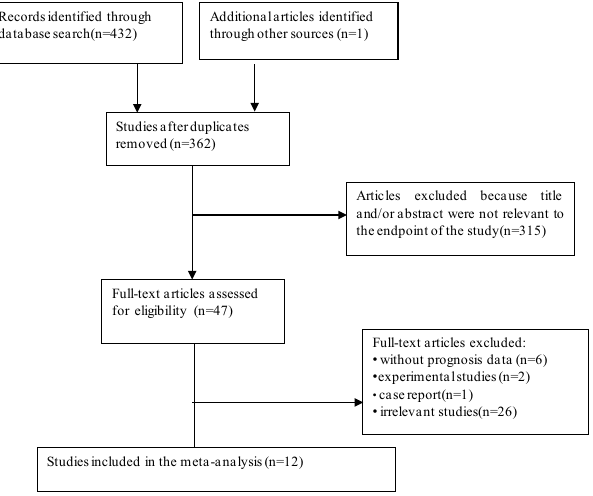
Figure 1. The flow chart of the selection process in our meta-analysis.